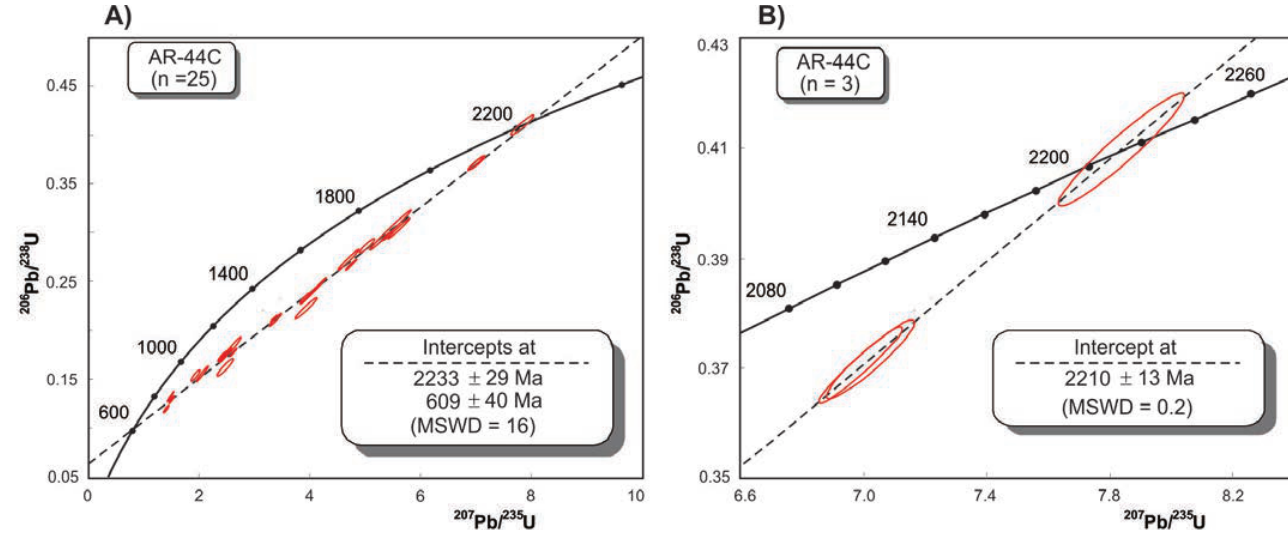
Figure 13 - Concordia diagrams for augen gneiss zircons between 121 and 122 m